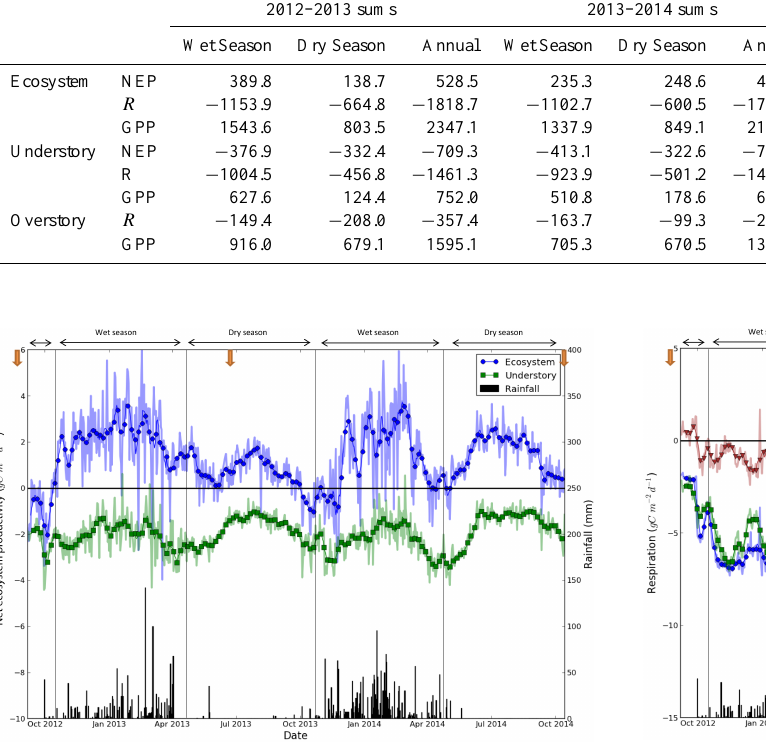
Figure 4. Respiration ( R ) for savanna ecosystem (23m tower), un- derstory (5m tower) and overstory (difference between 23 and 5m towers) components at the Howard Springs OzFlux site, Northern Territory, Australia from September 2012 to October 2014. Data shown are daily R totals with a 10-day running mean to aid visual- isation. Orange arrows represent the timing of fire events. Positive fluxes indicate a net sink of carbon to the savanna whereas negative fluxes are a net source of carbon to the atmosphere. Rainfall is also included as daily